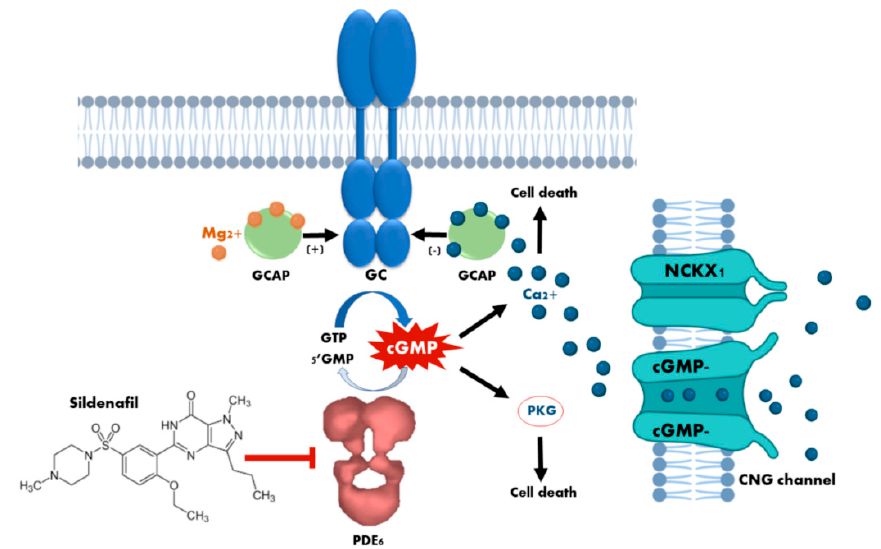
Figure 1. Cytotoxicity mechanisms of cyclic guanosine monophosphate (cGMP) in photoreceptors. The loss of phosphodiesterase (PDE6) function, or the prolonged activation of retinal guanylyl